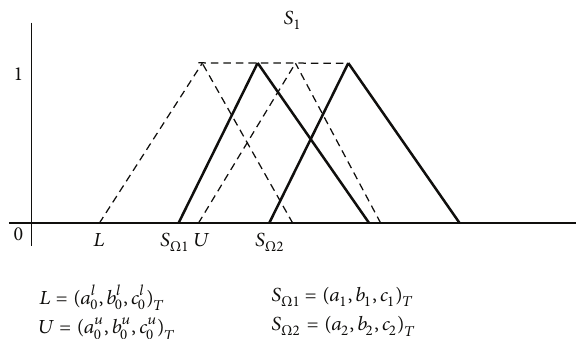
Figure 5: Graphical representation for accepting 𝐻 𝜑 (rejection of all samples) (graph for 𝑆 𝜑